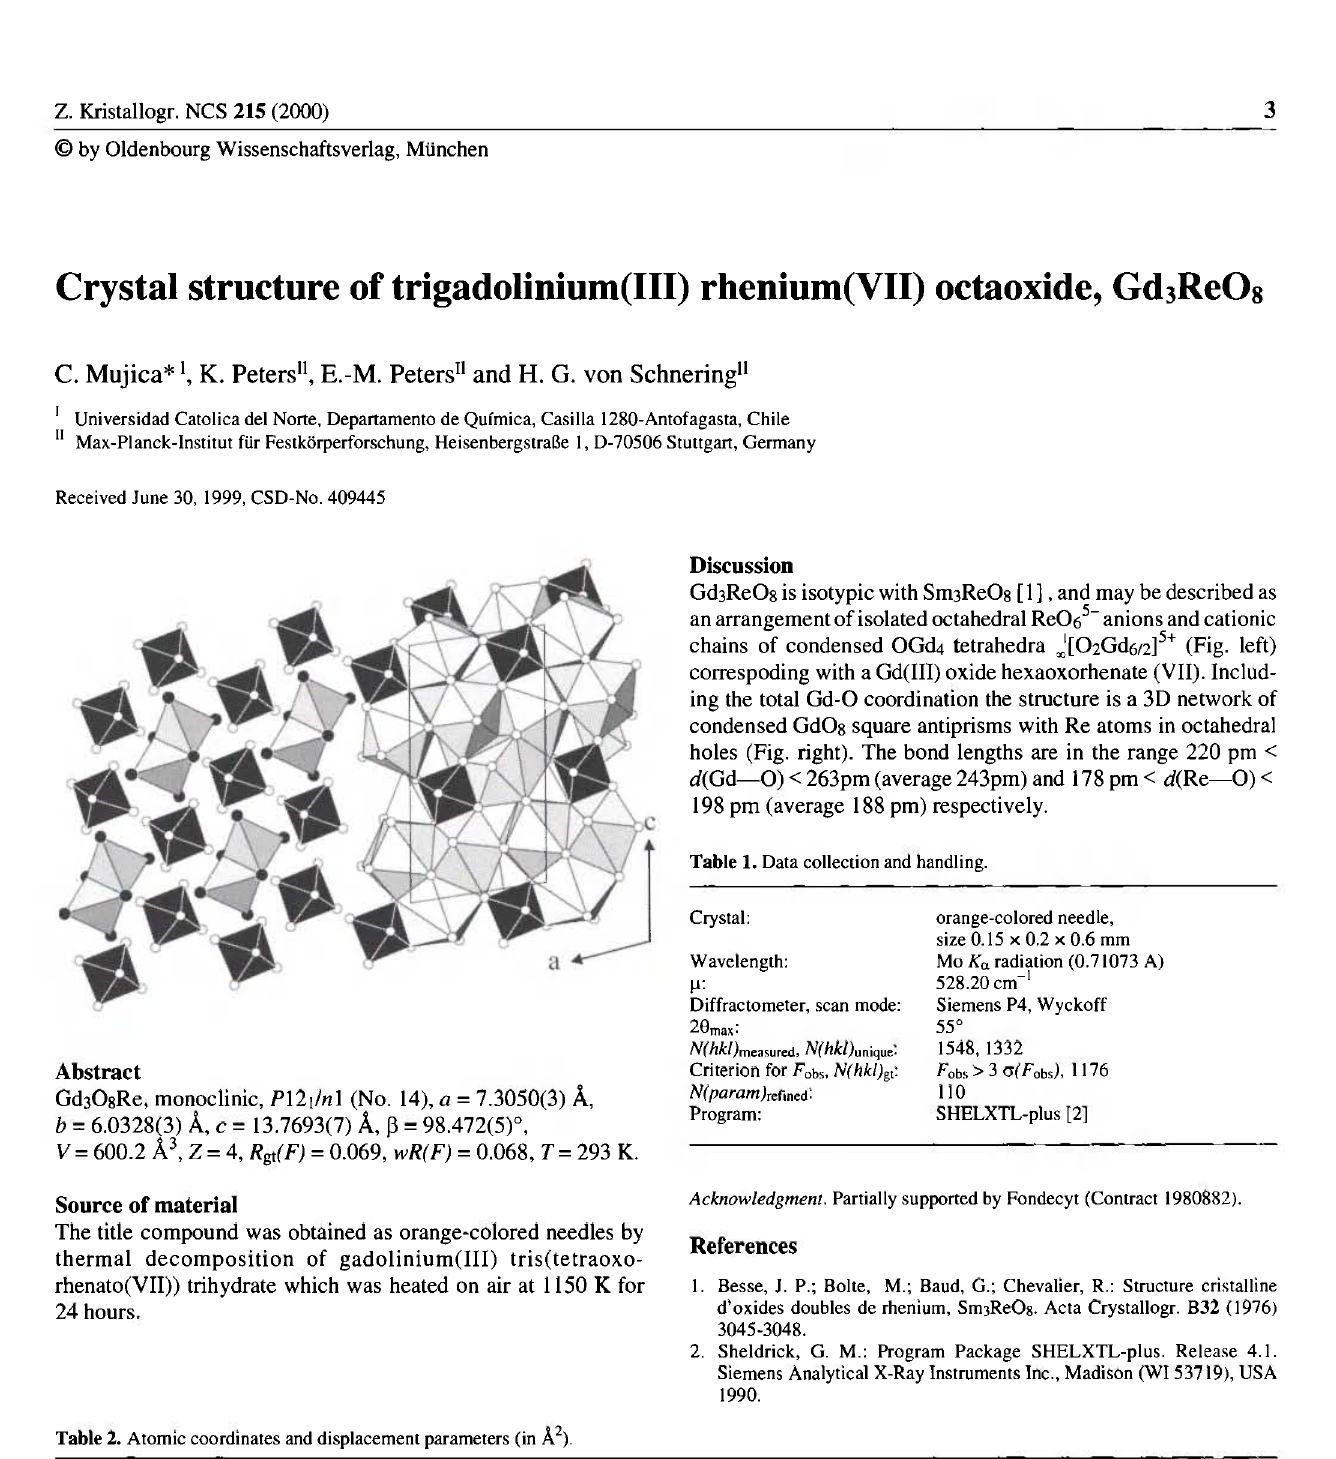
Table 2. Atomic coordinates and displacement parameters (in Ä 2 ).